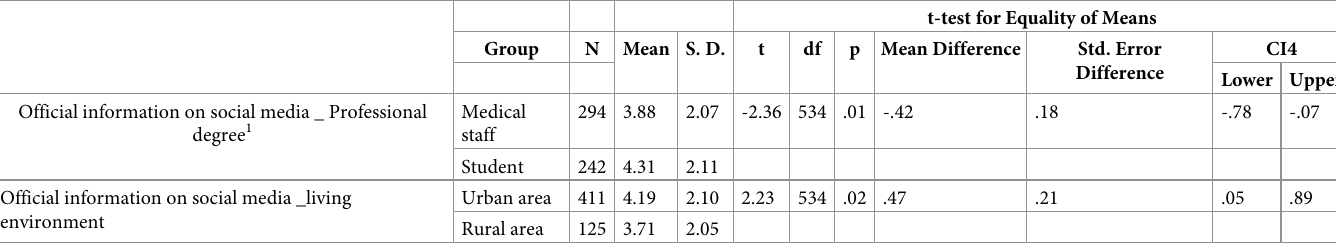
Table 10. Significant t tests for sharing official information on social media professional degree and living